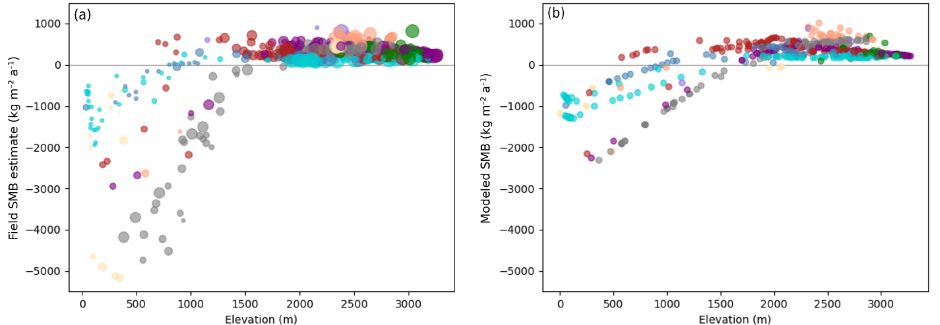
Figure 15. Field estimates of annual SMB as a function of observed elevation (a) and CESM annual SMB as a function of model elevation (b) from both accumulation and ablation zones. For the observed data, the size of the point represents the number of years in the field record, with larger points containing comparatively more temporal information than smaller points, and each point represents an annual surface mass balance estimate averaged across at least 1 year of data. For the modeled data, each point represents a model cell containing an available field estimate location. In both figures, colors correspond to the drainage basins as shown in Fig. 1.